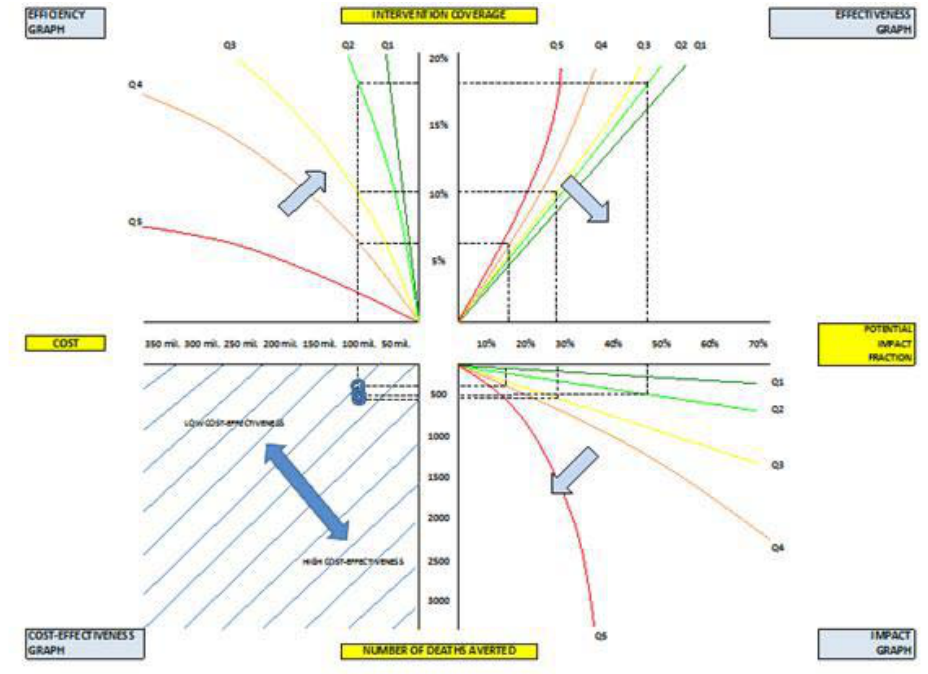
Figure 1 Conceptual framework for EQUIST [6], demonstrating a hypothetical planning exercise assessing the cost–effectiveness of delivery of a new intervention to different equity strata in the population (quintile Q2 vs Q3 vs Q4) with a fixed